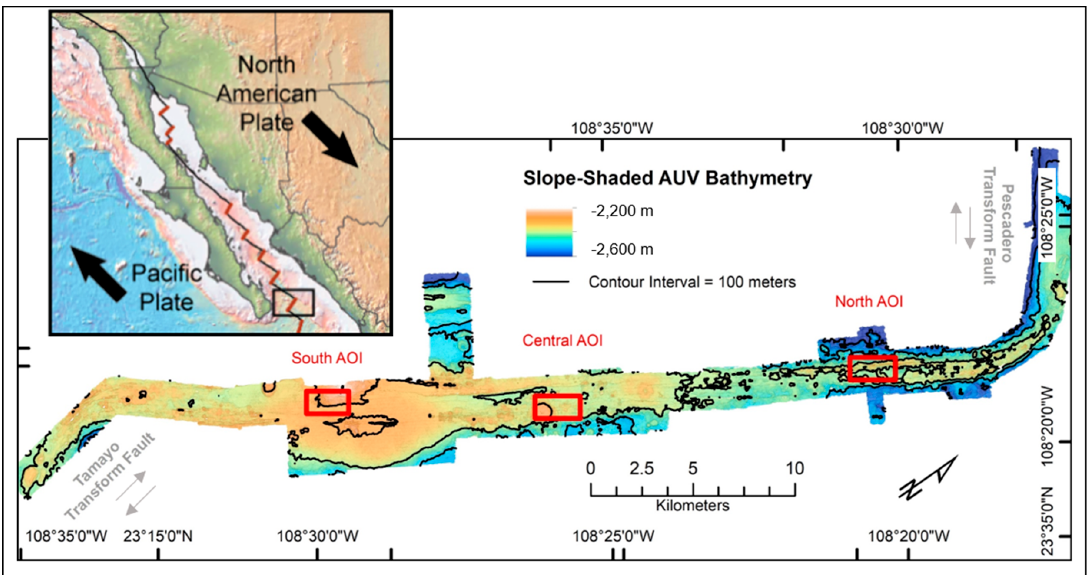
Figure 1. The Alarcon Rise is the south en-echelon ocean spreading ridge in the Gulf of California (black box in inset). Note that the map is oriented with north toward the upper right, and coordinate tics are spaced at 5 arc-minute intervals. The entire area of autonomous underwater vehicle (AUV) bathymetry at the Alarcon Rise is our study area, and three Area of Interest (AOI) locations (red boxes) referred to in this study are the volcanic shield (South AOI), volcanic cone (Central AOI), and high-silica ridge (North AOI).